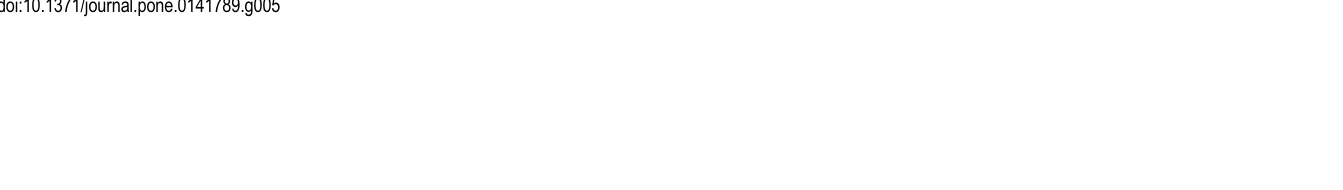
PLOS ONE | DOI:10.1371/journal.pone.0141789 November 6,